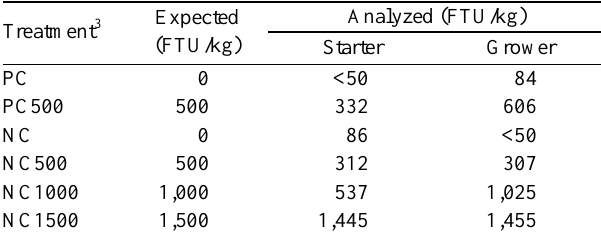
Table 2. Expected and analyzed 1 phytase activity (FTU 2 /kg)